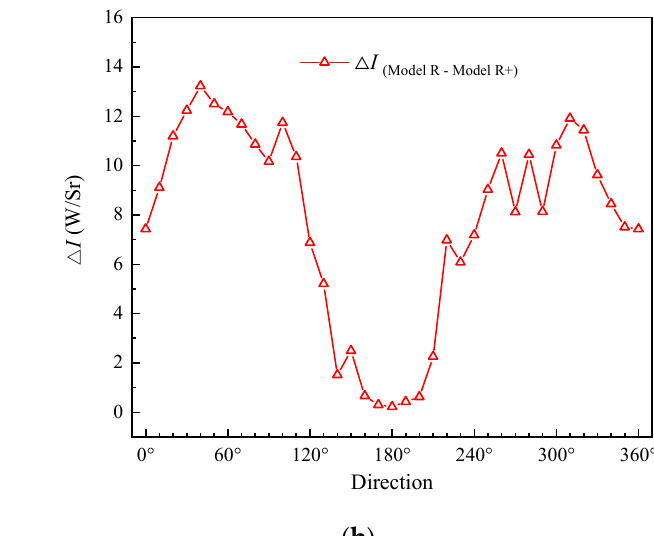
Figure 19. Infrared radiation intensity distribution of Model R and Model R+ in 8–14 µm band. ( a ) Infrared distribution characteristics; and ( b ) suppression value.